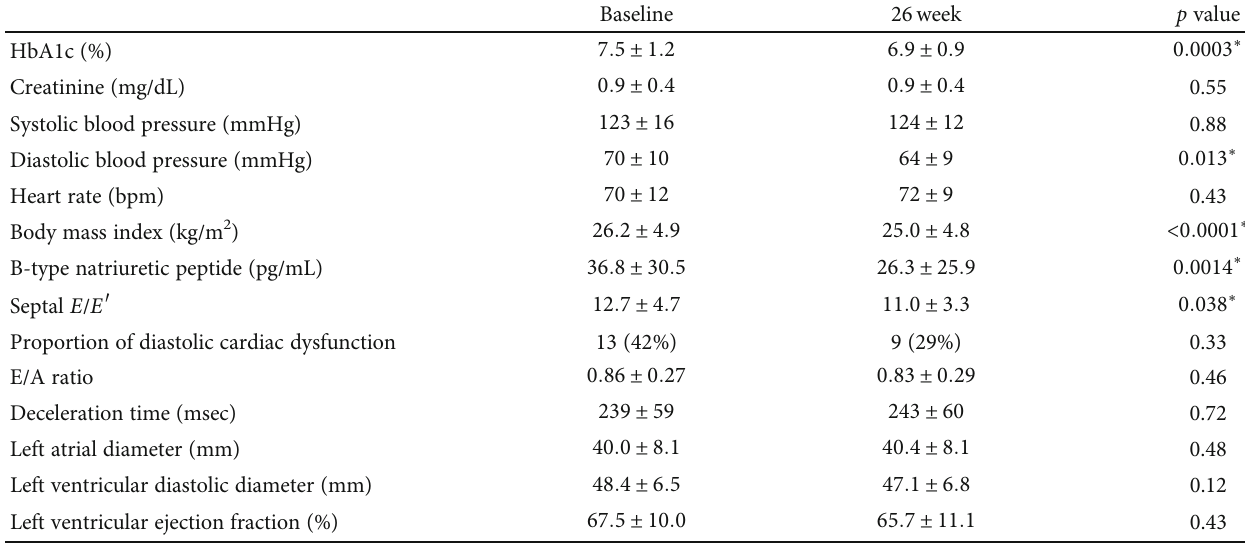
Table 2: Comparison of clinical parameters at baseline and after 26 weeks of liraglutide treatment.